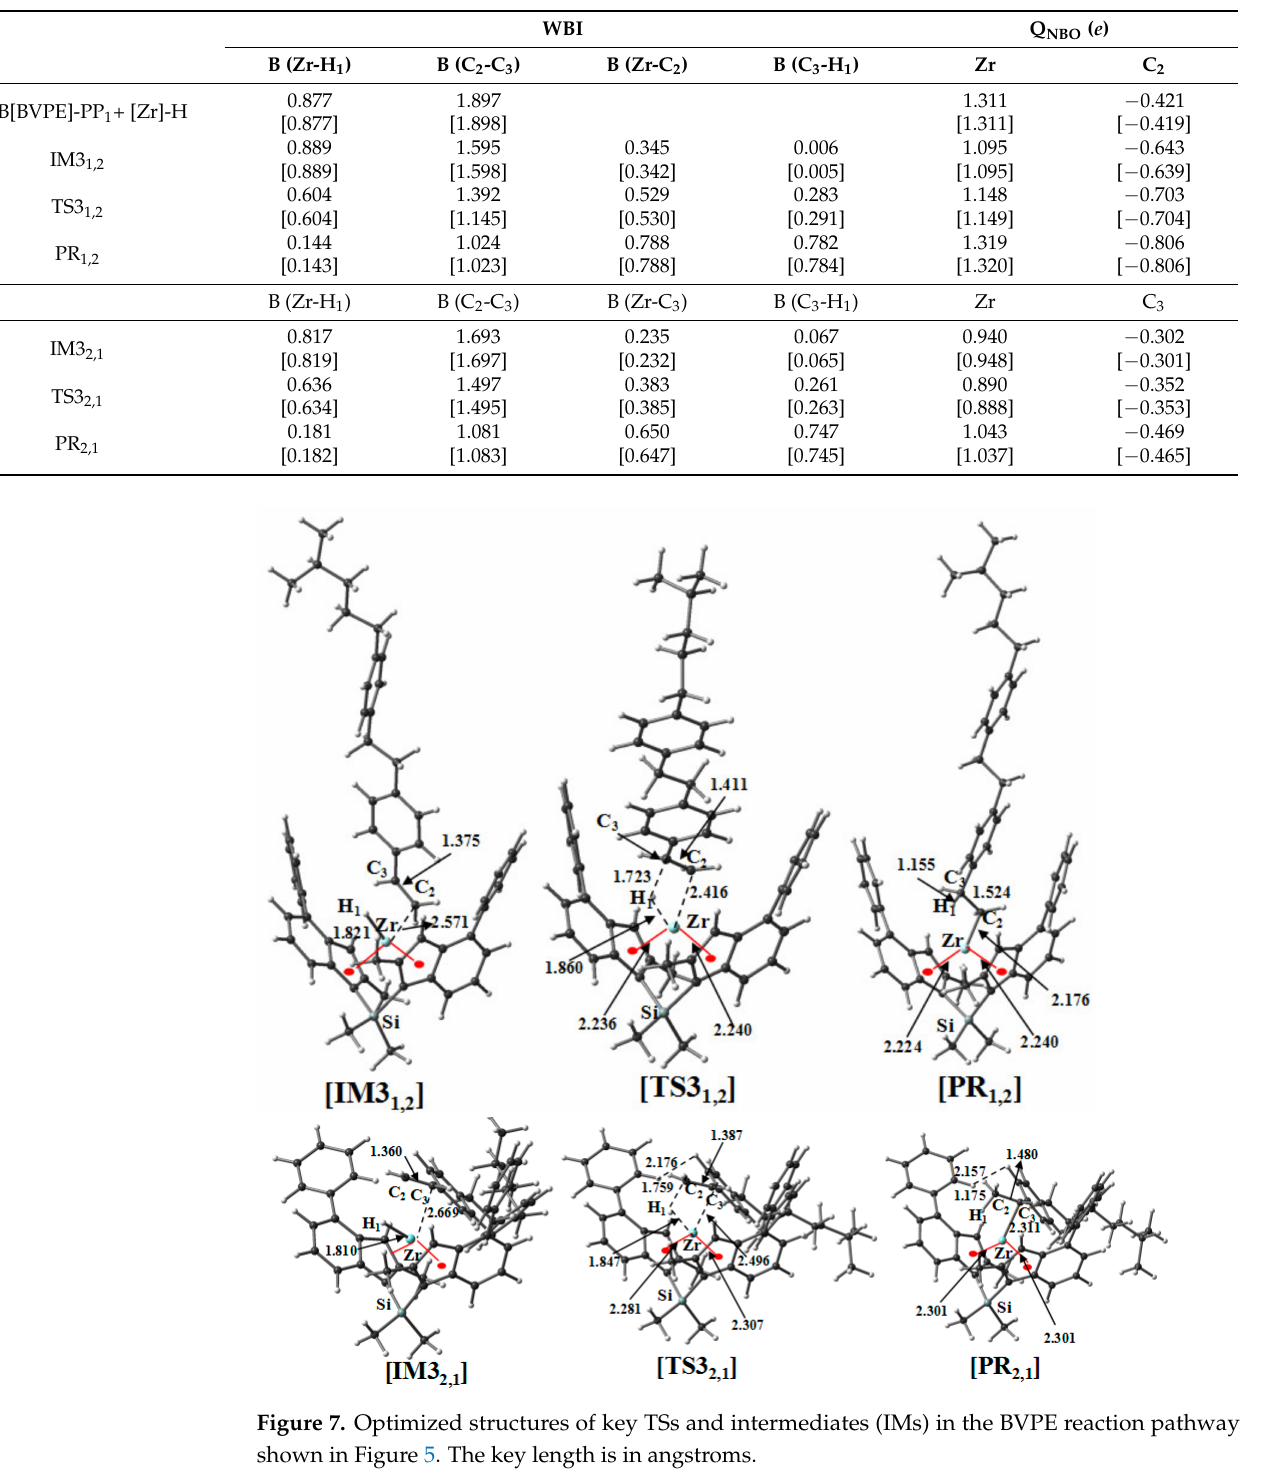
Table 2. The Wiberg bond indices (WBI) and natural charges (Q NBO ) for some key bonds and atoms for the reaction pathway of the second vinyl bond insertion; the values of BVPE are given in brackets.